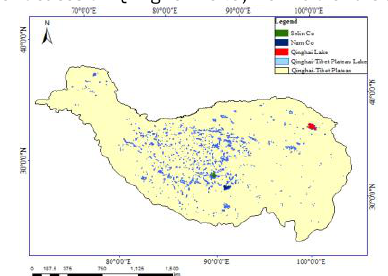
Figure 1. Schematic diagram of geographical location of the Qinghai-Tibet Plateau 2.1.1 Qinghai Lake : Qinghai lake is located in the Qinghai